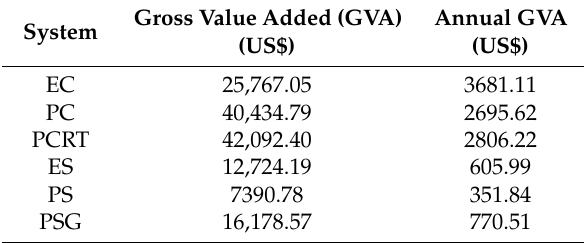
Table 4. Gross value added (GVA) generated by the industrial phase of production systems.